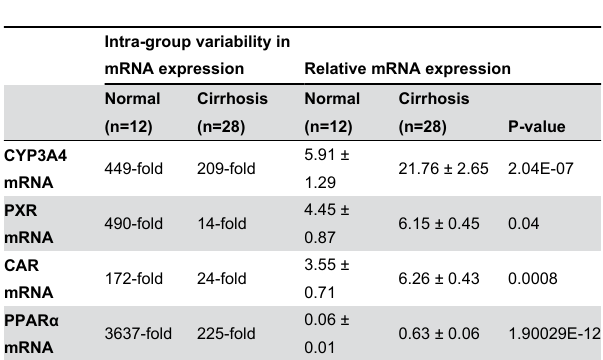
Table 3. CYP3A4, PXR, CAR and PPARα mRNA expression in cirrhotic and normal liver